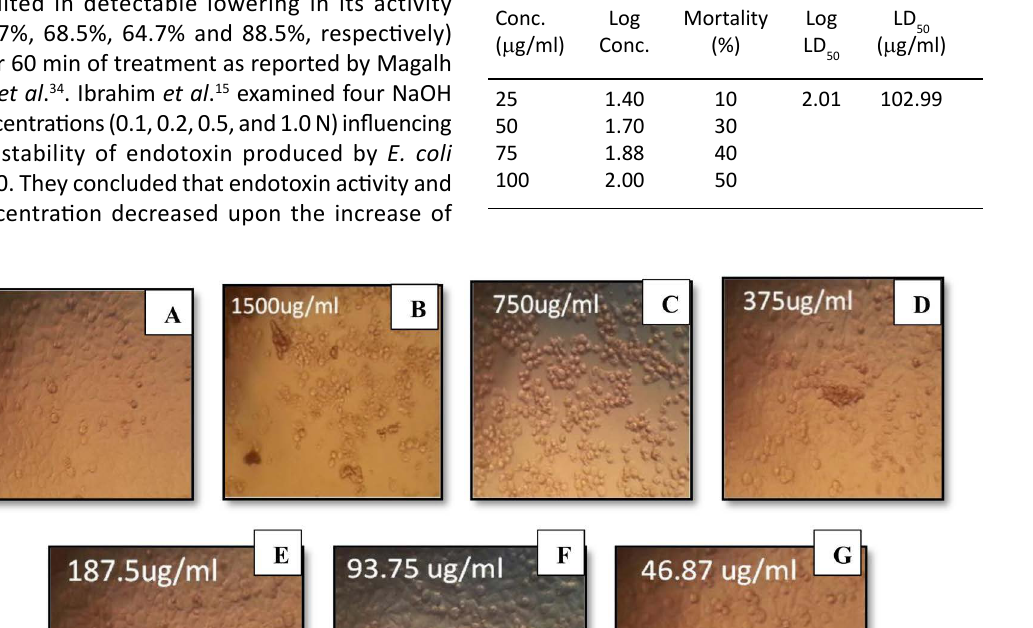
Table 2. Bio-toxicity of different endotoxin concentrations produced by P. aeruginosa ATCC 9027